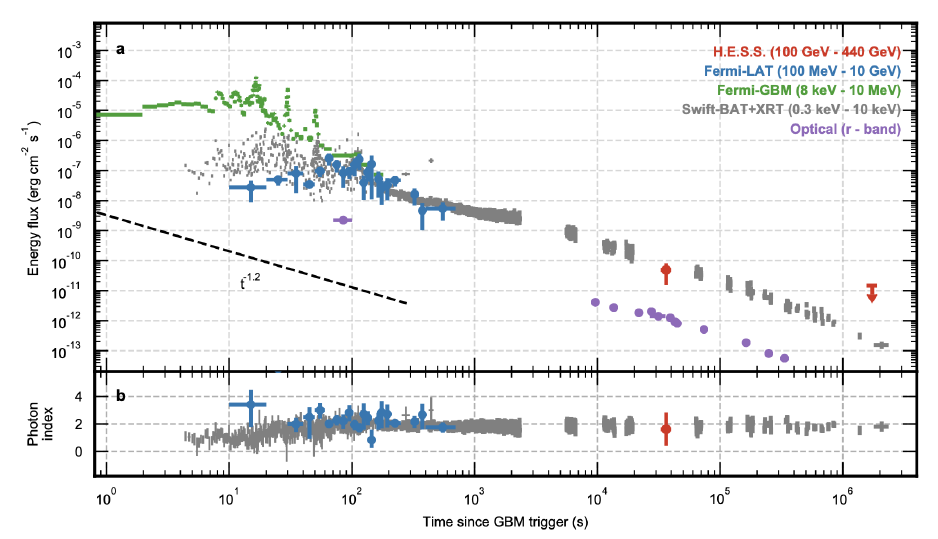
Figure 4. Temporal evolution of the emission from GRB 180720B. Upper panel: light curve detected by GBM (green), LAT (blue), and XRT (grey). The early 0.3–10keV lightcurve is derived extrapolating the BAT spectra (15keV–150keV) to the XRT band (0.3–10keV). The optical ( r -band) lightcurve is also shown (purple). The 0.1–0.44TeV flux inferred from H.E.S.S. observations is shown with a red circle. Observations at 18days did not show any evidence for a VHE excess from the source (red arrow, upper limit at 95% confidence level). Bottom panel: photon index of the LAT and Swift and H.E.S.S. spectra (error bars at 1 σ ). From